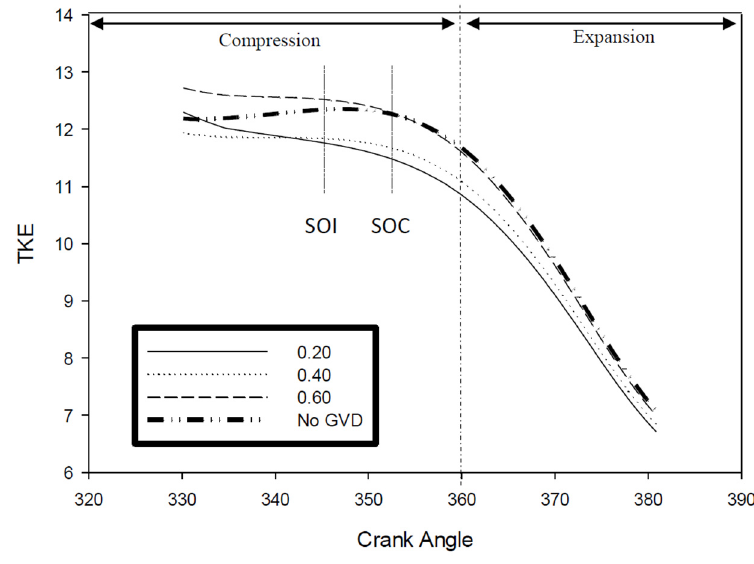
Figure 8. In-cylinder turbulence kinetic energy (TKE) against crank angle ( θ ).